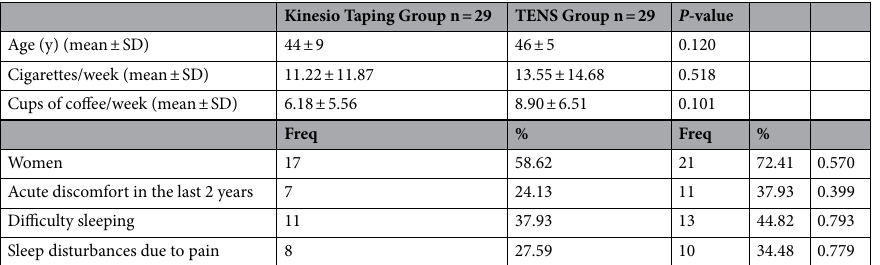
Table 1. Characteristics of patients at baseline. Values are expressed as absolute and relative frequencies for categorical variables and as means ± standard deviation for continuous variables. Cigarettes/week (cigarettes smoked per week), cups of coffee/week (cups of coffee drunk per week).